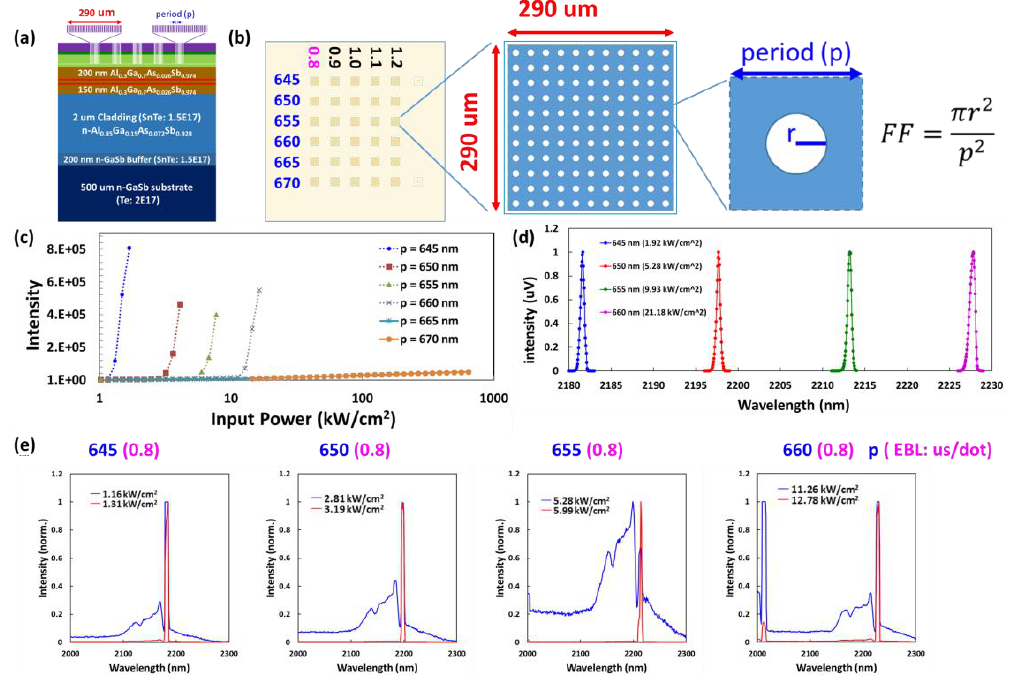
Figure 5. ( a ) Cross-section view and ( b ) top view of sample A; the figures are not drawn to scale (piece 1). ( c ) Light-in versus light-out (L-L) curve of a circular PCSEL device with periodicity between 645–670 nm and an e-beam lithography (EBL) dose duration of 0.8 us/dot. ( d ) Normalized above-threshold lasing spectra and ( e ) normalized emission spectra in the immediate vicinity of the lasing threshold for the lasingable period (645 nm to 660 nm) with an EBL dose duration of 0.8 us/dot. The lasing